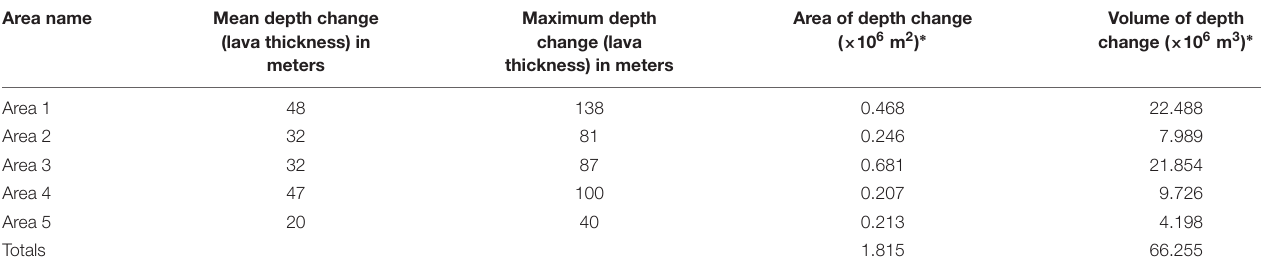
TABLE 1 | Estimates of the thicknesses, areas, and volumes of new lava flows, based on depth changes between 2013 and 2015 bathymetric surveys.